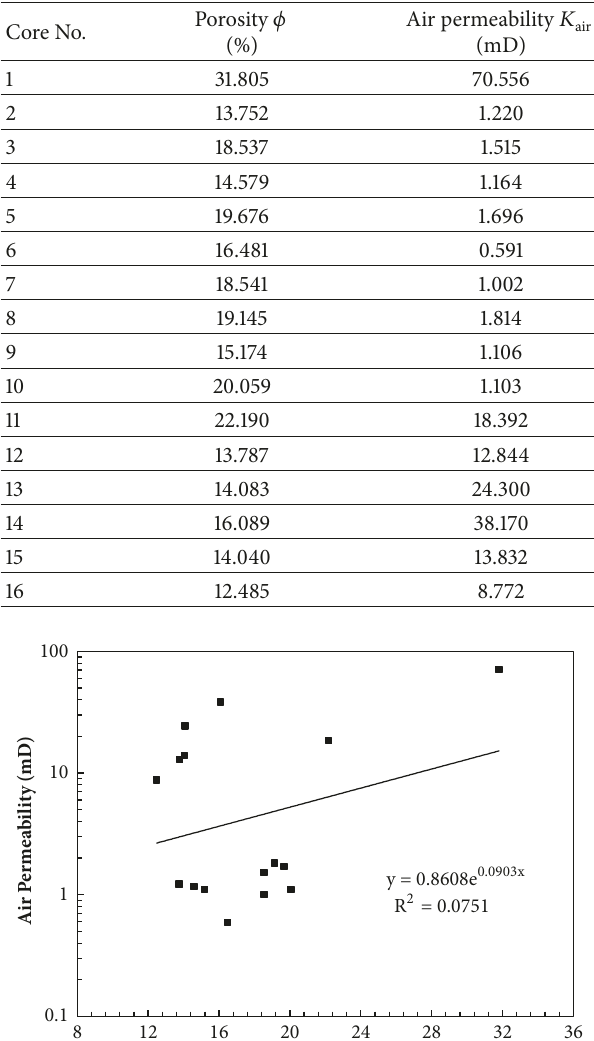
Table 1: Air permeability and porosity of carbonate core samples.